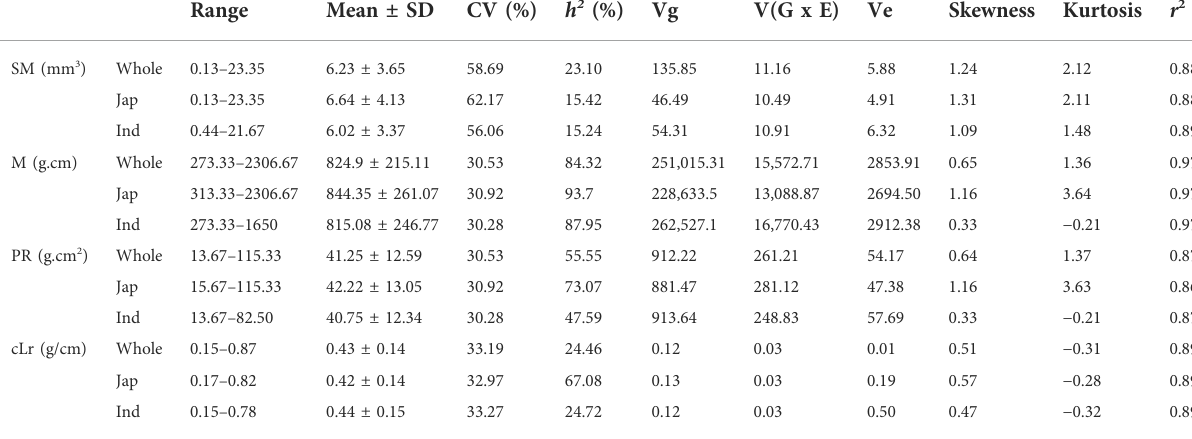
TABLE 1 Statistical descriptive of four culm lodging resistance – related traits in whole population and japonica and indica subpopulations.